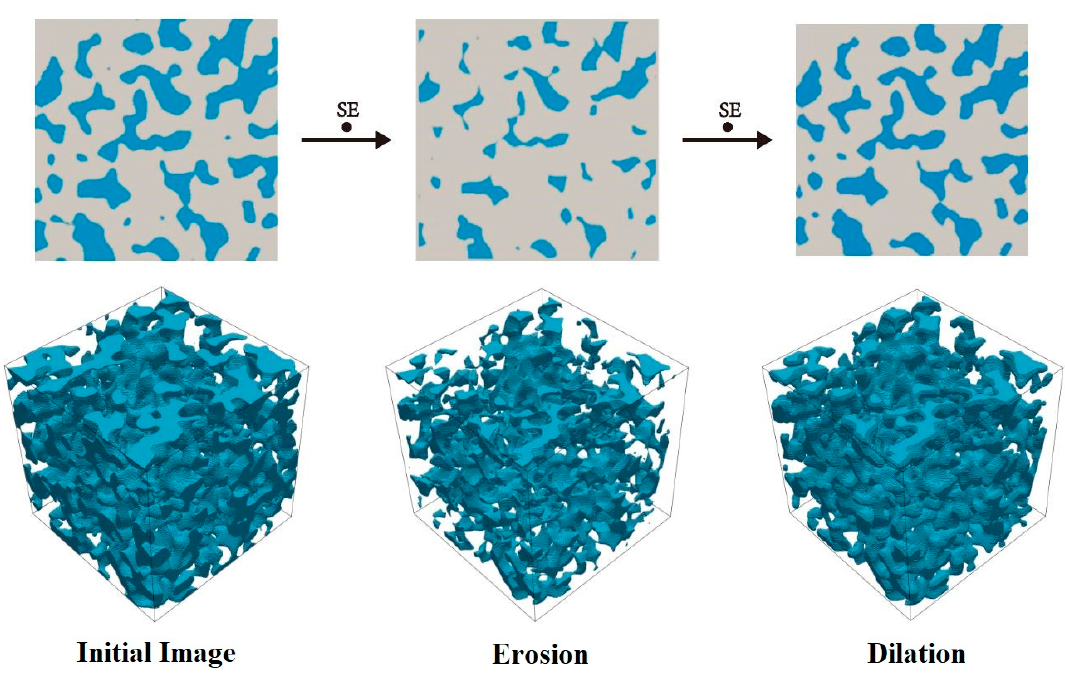
Figure 9. Operation of MO.